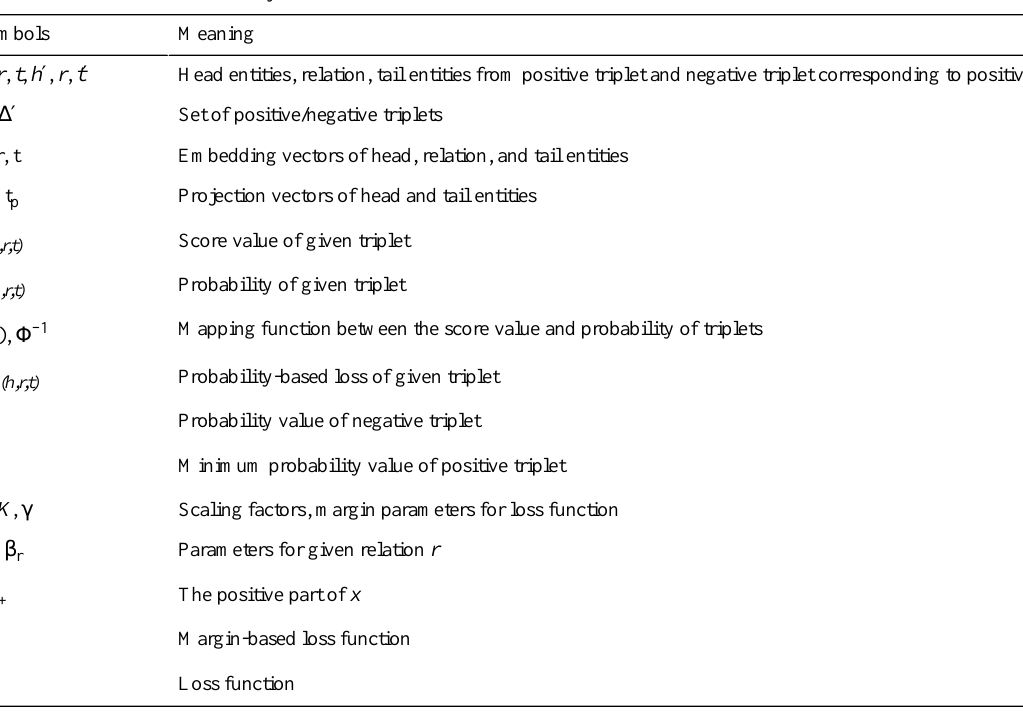
Table 1. Notations used in the study. MeaningSymbols